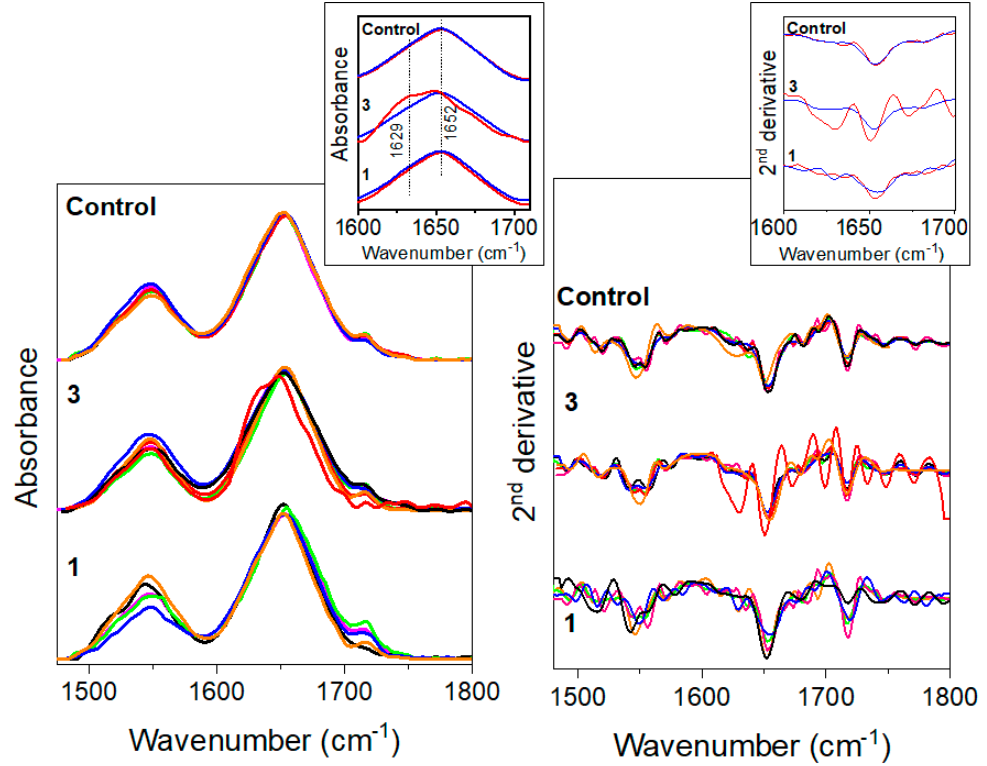
Figure 2. Amide_IR: (left) FTIR spectra and (right) second-derivative of FTIR spectra in the region of amide bands for the control samples (upper part), for fractions 3 (in the middle) and 1 (on the bottom) of the patients considered in this study. Each patient is associated with a specific color: patient 1 is depicted in black, patient 2 in red, patient 3 in blue, patient 4 in pink, patient 5 in orange and patient 6 in green. In the insets, aimed at elucidating the major differences in protein secondary structure